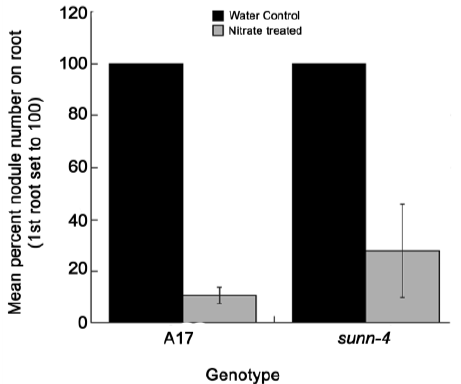
Figure 3. Effect of ammonium nitrate versus water treatment of first root on nodulation of second root in a split root system. Split root plants were grown as in [27] and the first root fed with either water or 10 mM NH 4 NO 3 for four days before inoculating the second root. Nodules were counted on the second root of A17 (wild type) plants ( n = 12) and sunn-4 plants ( n = 7) 20 days after inoculation and expressed as percentage of the water controls. Bars indicate standard error of the percentage means calculated by Taylor series